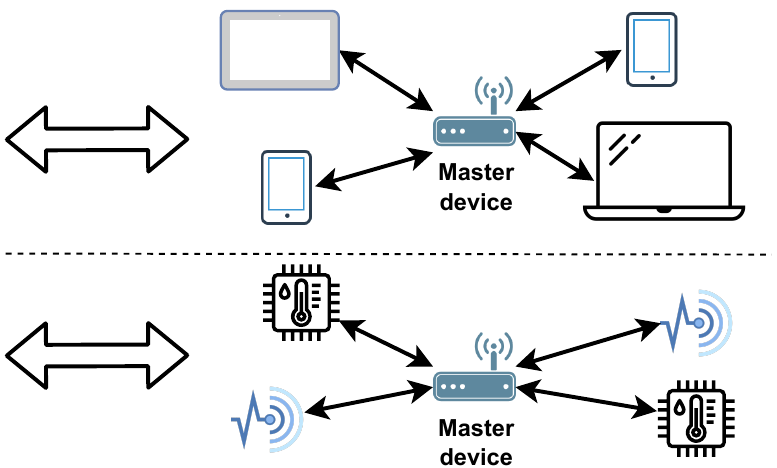
Figure 3. Horizontal scalability with centralized approach achieved by offloading to a master device on the same architectural